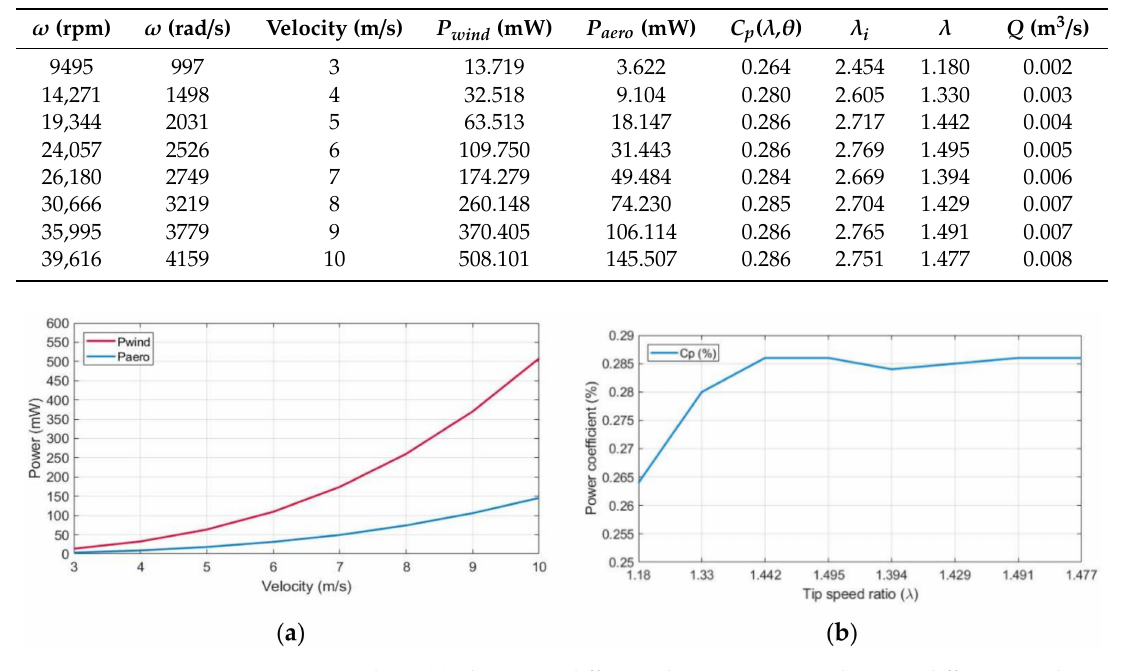
Figure 6. Open space system values. ( a ) The power di ff erence between P wind and P aero at di ff erent wind velocities. ( b ) Aerodynamic e ffi ciency at the same